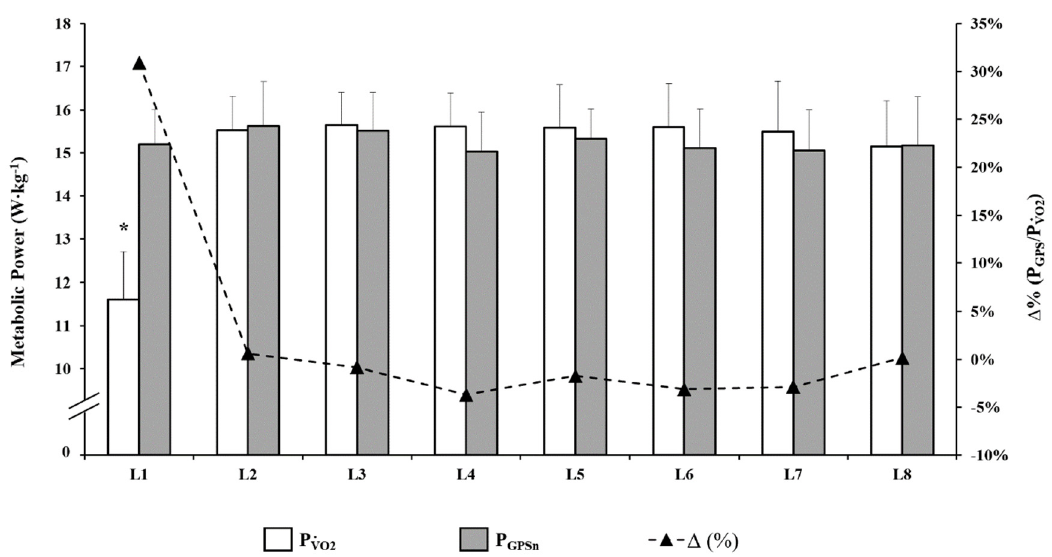
Figure 7. Metabolic power using either traditional calorimetry with oxygen uptake ( P (cid:2906)(cid:4662)(cid:2899) locomotor-related metabolic power (P GPSn ) during the 8 laps of soccer-specific circuits (L1–L8). Statistical significance is denoted as “*”— p < 0.05.